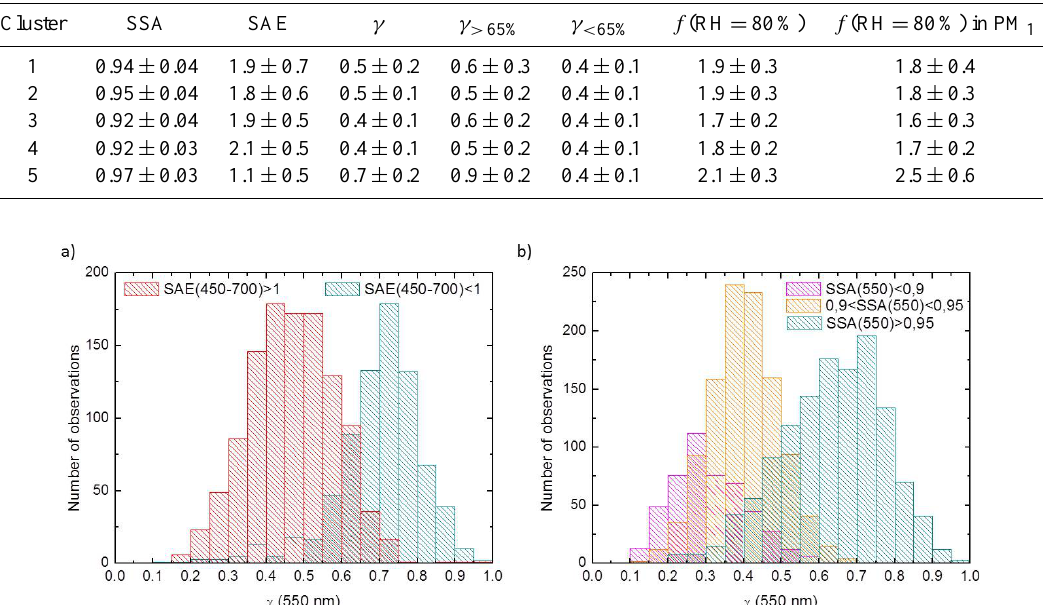
Table 3. Mean and standard deviation of single scattering albedo, scattering Ångström exponent, γ parameter, γ > 65% , γ < 65% and scattering enhancement factor at 80% RH for the five clusters. All the variables refer to PM 10 unless specifically noted and to 550nm except the scattering Ångström exponent that has been calculated between 450 and 700nm.